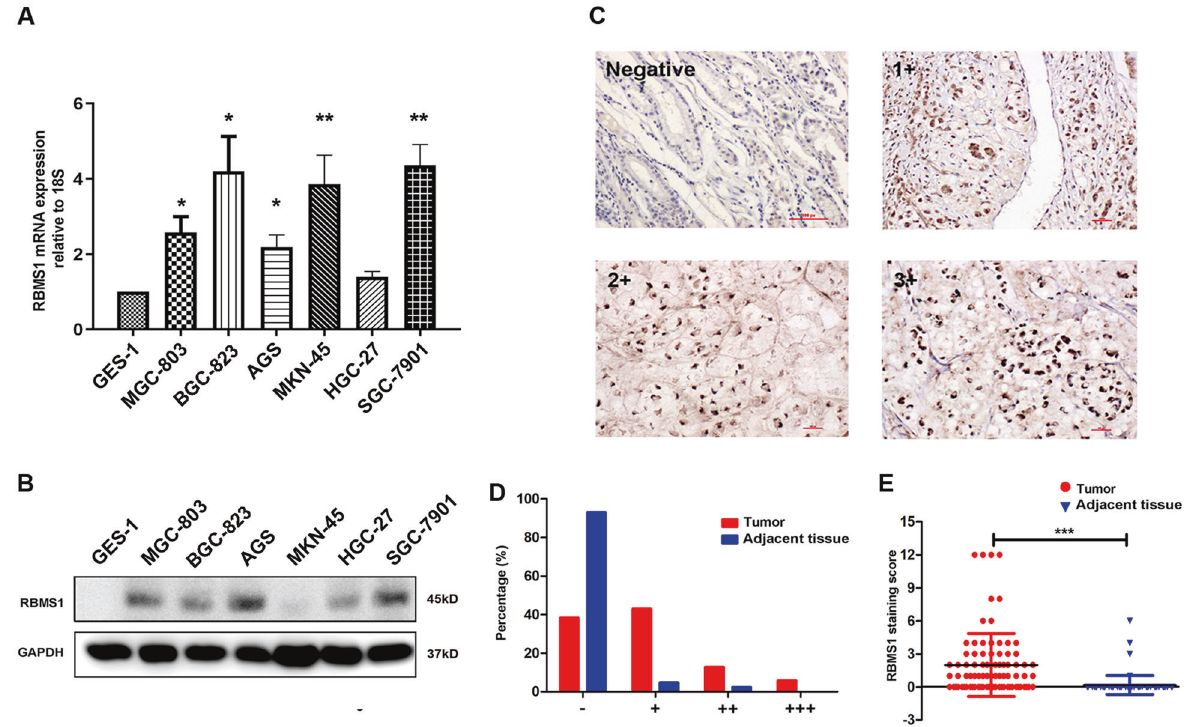
Fig. 1 RBMS1 is upregulated in GC tissues and cell lines. A RBMS1 mRNA and protein expression ( B ) were detected by RT – PCR and western blot analysis in the GES-1, MGC-803, BGC-823, AGS, MKN-45, HGC-27, and SGC-7901 cell lines. C The expression levels of RBMS1 in GC